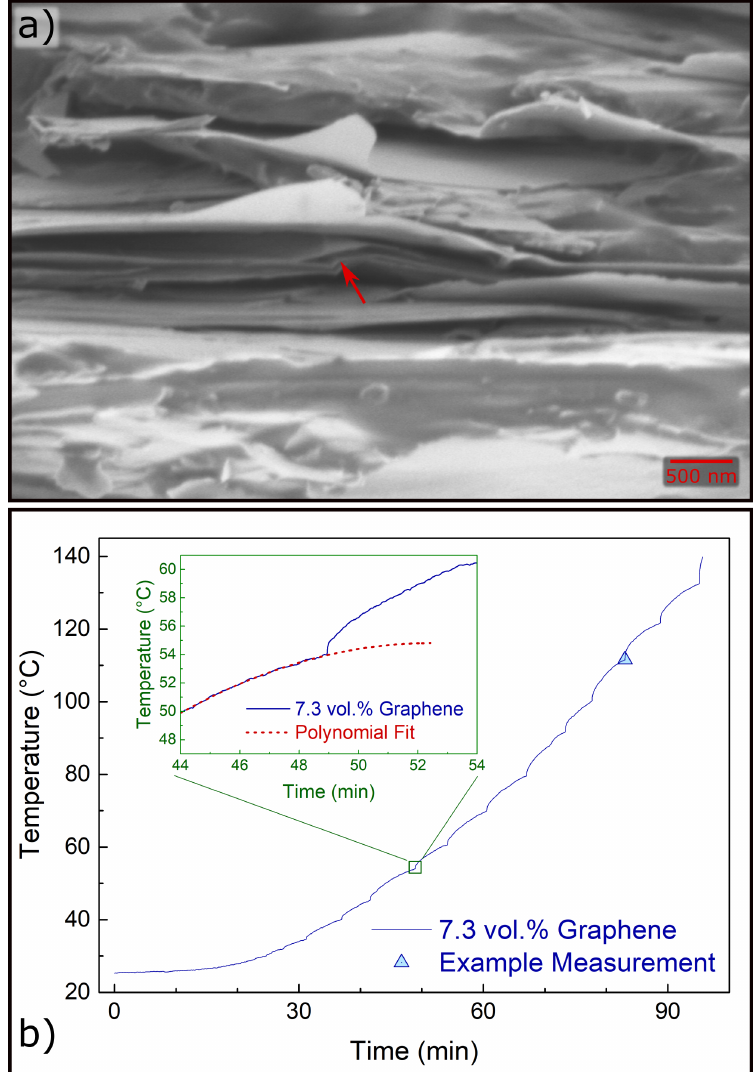
Figure 3. ( a ) Pseudo-colored SEM of a representative FLG composite with an arrow pointing to a definite FLG flake. ( b ) Thermocouple temperature readings over time in the course of an experiment. Recording the equilibrium temperature for the experimental vehicles with TIMs of DGEBA with FLG filler levels of 0 vol.%, 3.6 vol.%, and 7.3 vol.% showed that for comparable heating coil power levels increasing concentrations of FLG resulted in lower operating temperatures for the heating coil, as seen in Figure 4. At a total heat dissipation rate of 20 W, the operating temperatures were ≈ 108 ◦ C, ≈ 91 ◦ C, and ≈ 85 ◦ C for the 0 vol.%, 3.6 vol.%, and 7.3 vol.% samples, respectively. These operating temperatures correspond to a reduction in the increase of operating temperatures of 20% for the 3.6 vol.% TIM and 29% for the 7.3 vol.% TIM versus pure DGEBA. The modest non-linear behavior at the high power dissipation in the 7.3 vol.% data is attributed to the loosening of the conditions that define thermal equilibrium at higher temperatures, as discussed